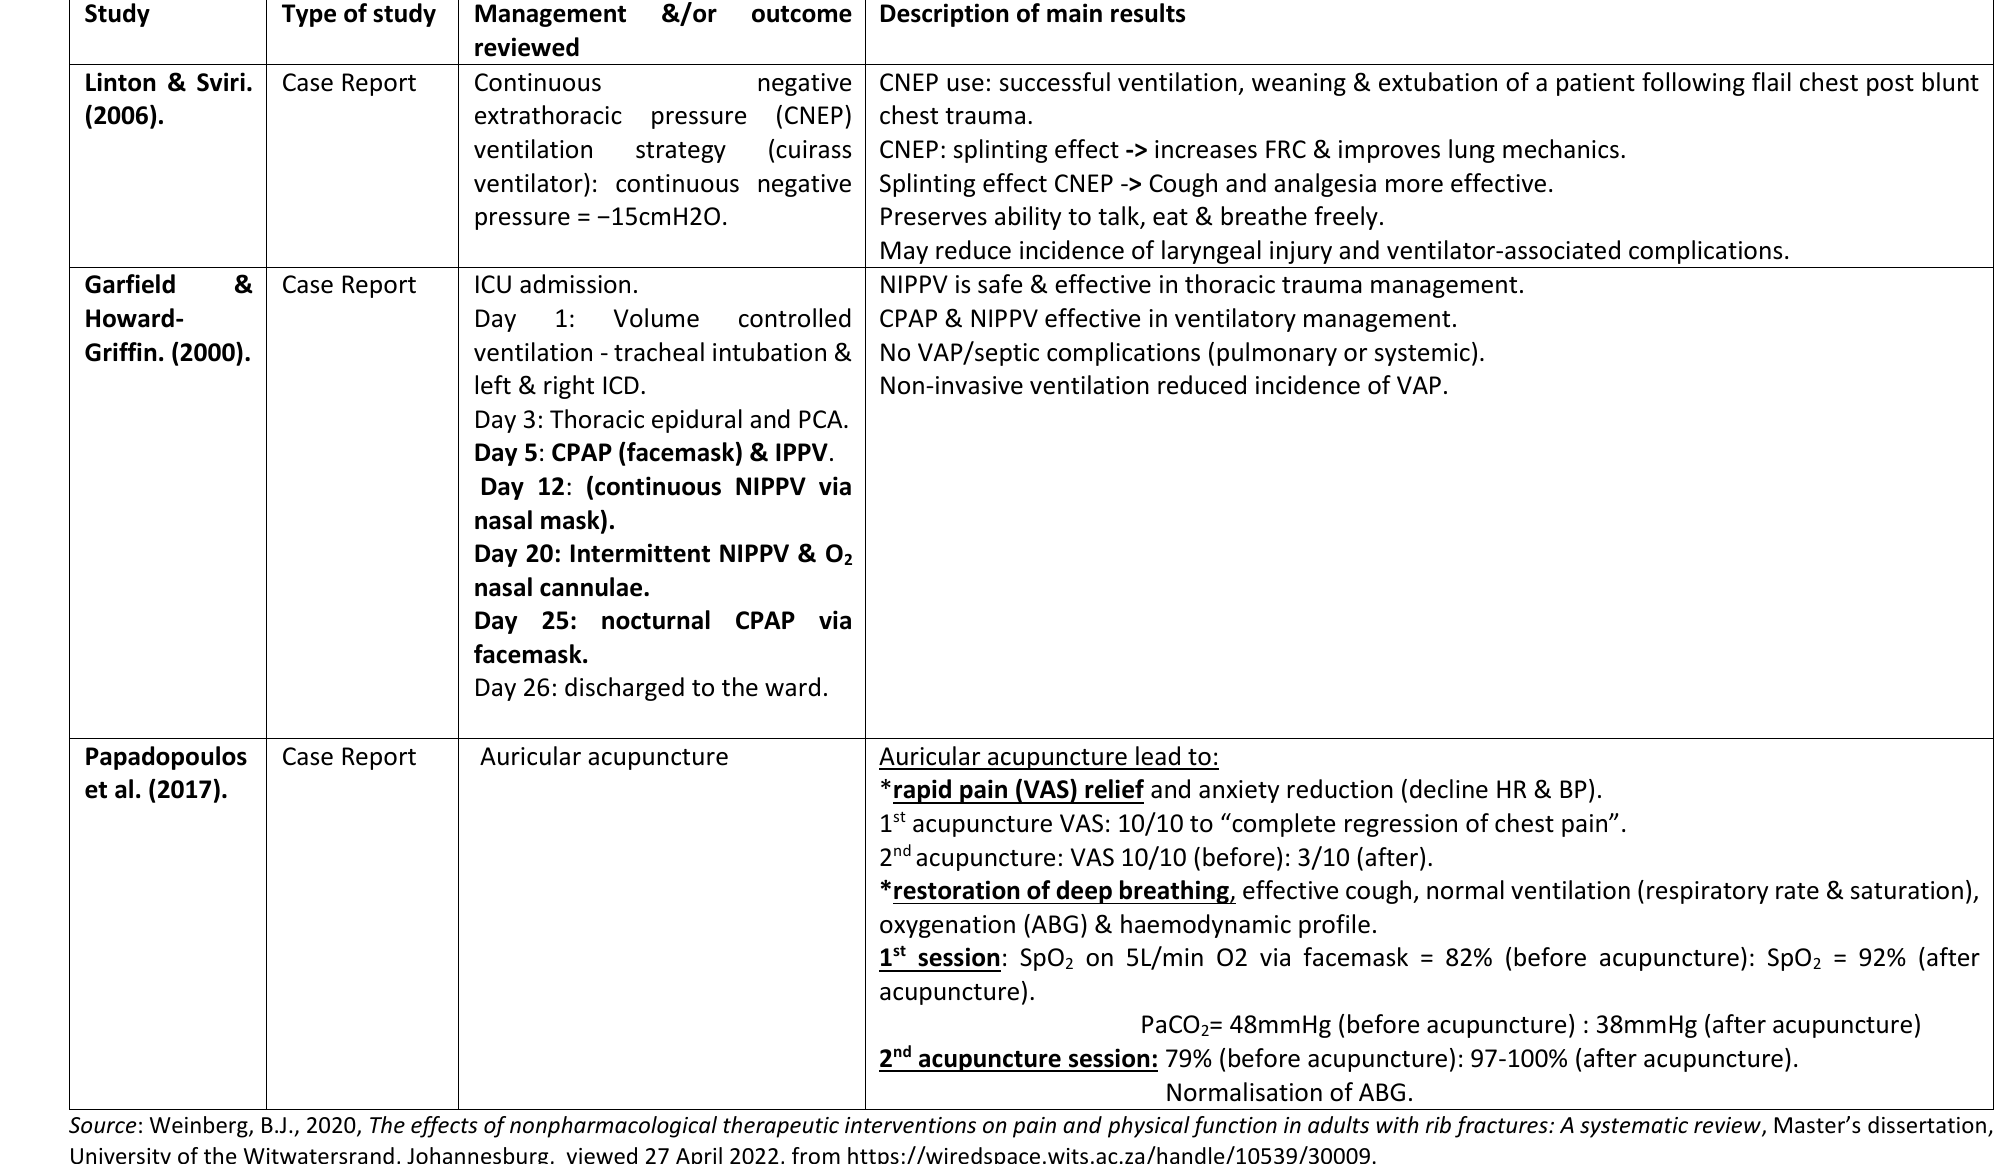
TABLE 14-A1: Management and final results of included case